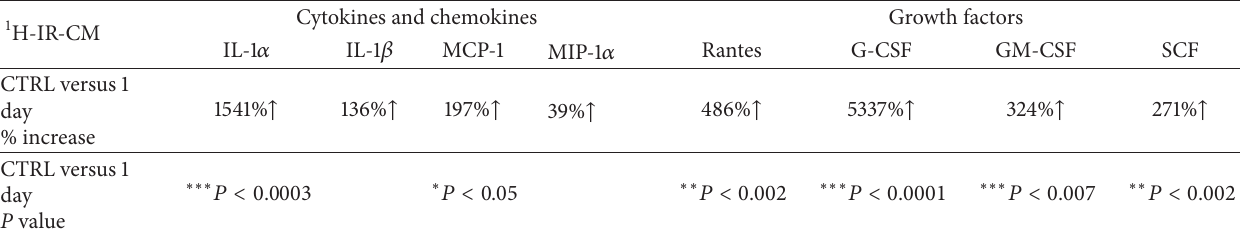
Table 1: Represents % change and statistical significance values in cumulative levels of cytokine, chemokine, and growth factors collected 24 h after treatment with 1 H-IR-CM, for control versus day